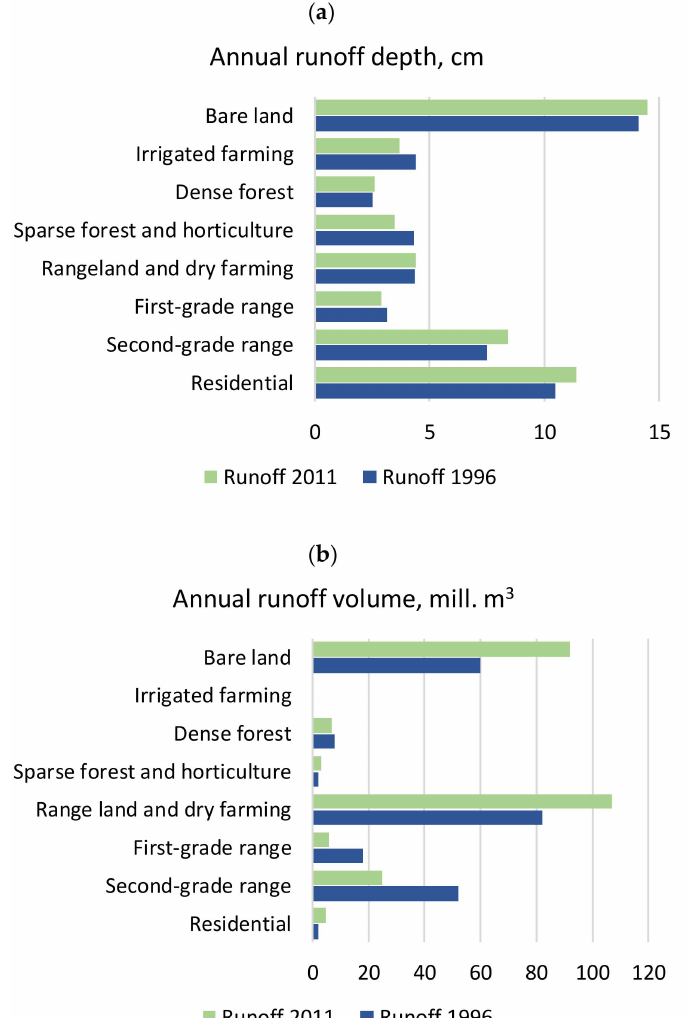
Figure 5. Mean annual runoff depths ( a ) and volumes ( b ) in different land-use classes in 1996 and 2011. Runoff depth is that part of annual precipitation (66.5 cm/year) that does not infiltrate the